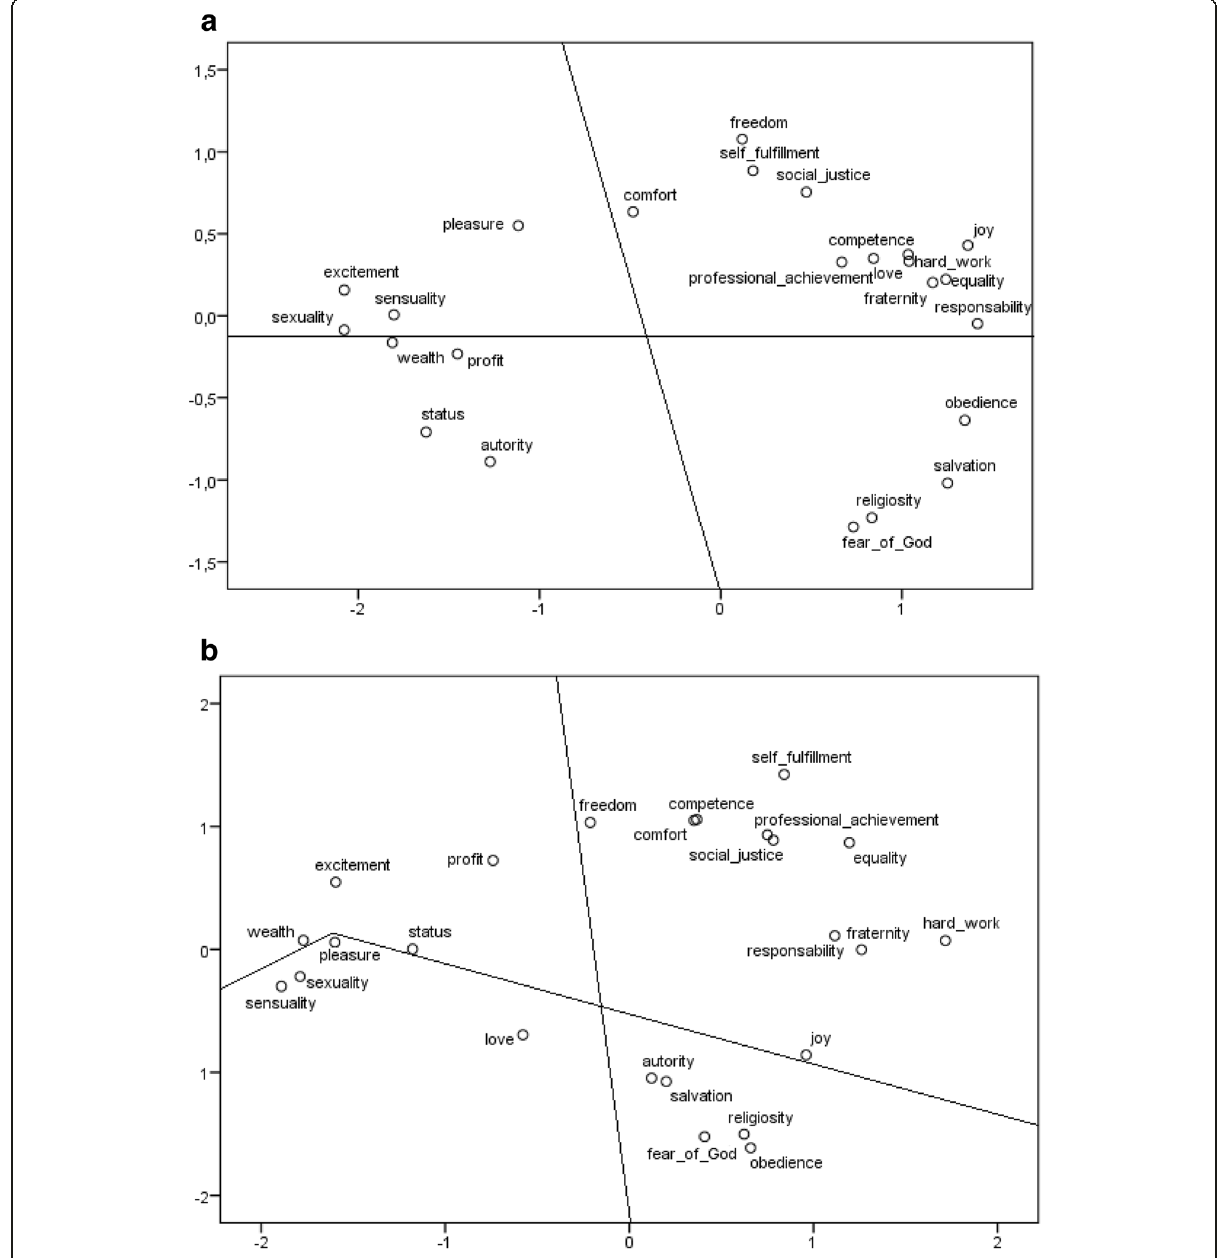
Fig. 2 Value structure in Brazilian ( a ) and Portuguese ( b ) teenagers